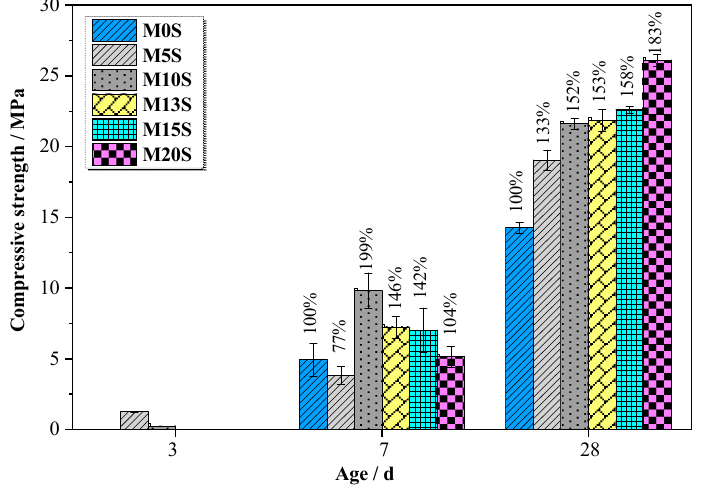
Figure 5. SEM images of 28d MASMs: ( a ) M0S; ( b ) M5S; ( c ) M10S; ( d ) M13S; ( e ) M15S; ( f ) M20S.